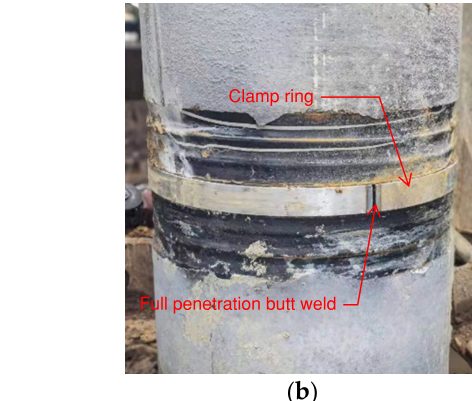
Figure 3. Force analysis.